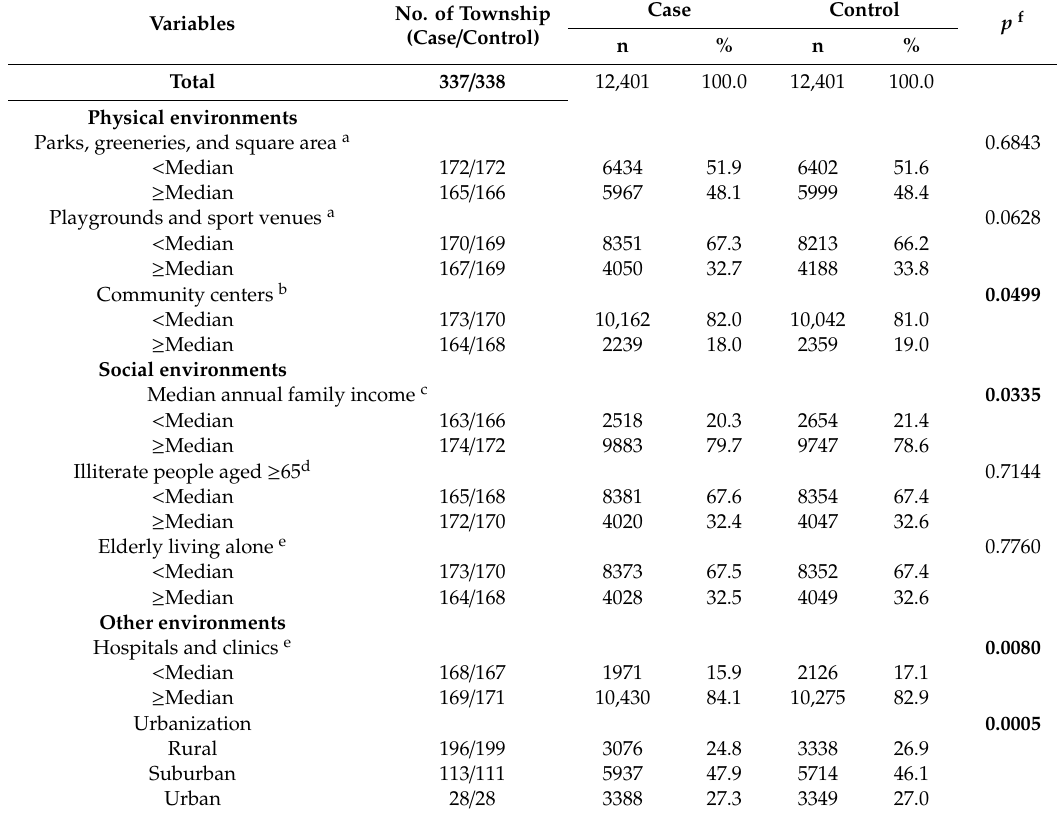
Table 3. Environmental features of township level in Alzheimer’s dementia cases and controls.